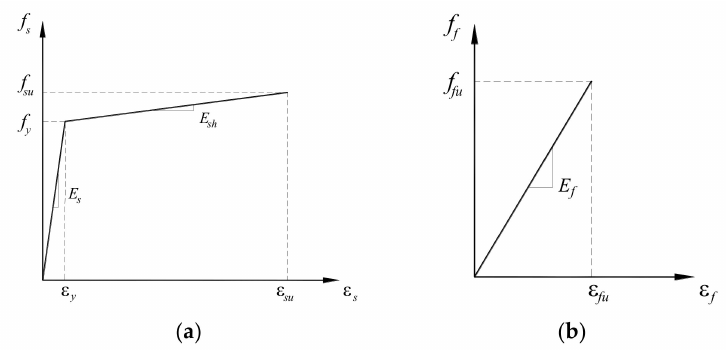
Figure 15. Constitutive laws of the reinforcement: ( a ) Steel bars; ( b ) Carbon fabrics.